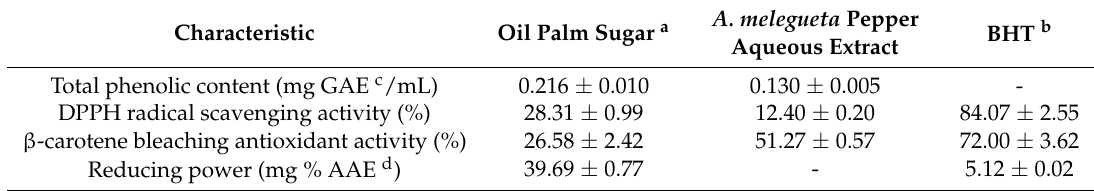
Table 5. Antioxidant capacity values for oil palm sugar solution, A. melegueta pepper extract, and BHT.